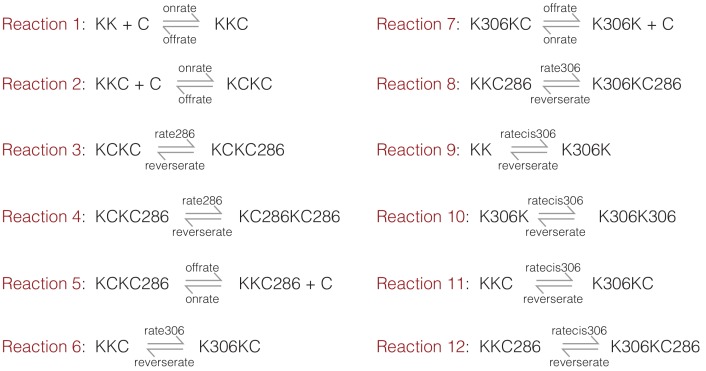
A summary of the reactions considered in the kinetic model.K denotes the kinase (CaMKII) and C denotes CaM. Phosphorylation on Thr 286 or Thr 305/306 is denoted by 286 and 306, respectively.